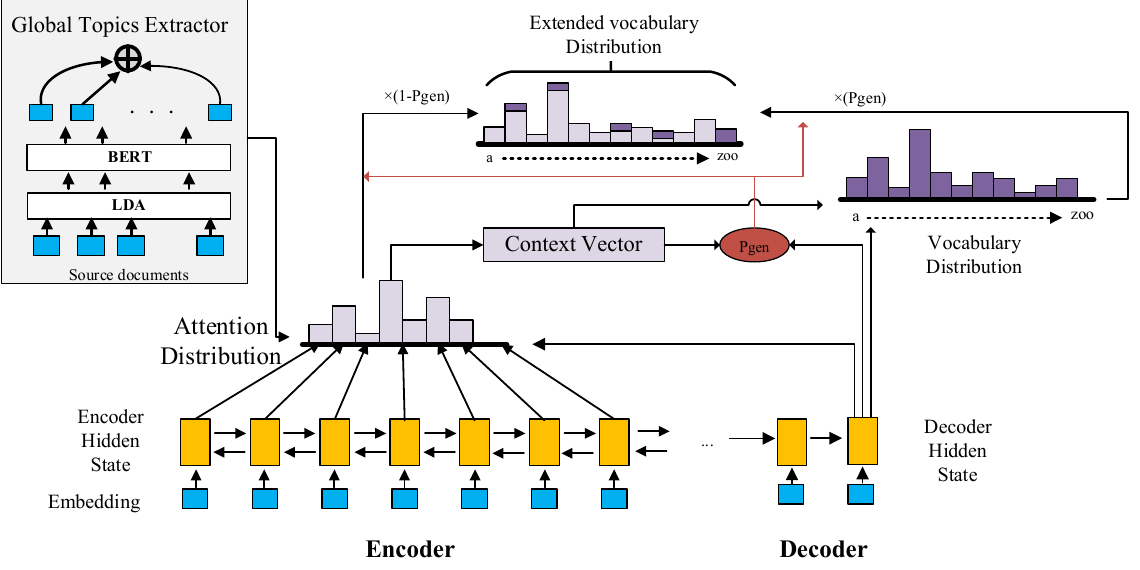
Figure 2. An abstract summarization method combining global topics.